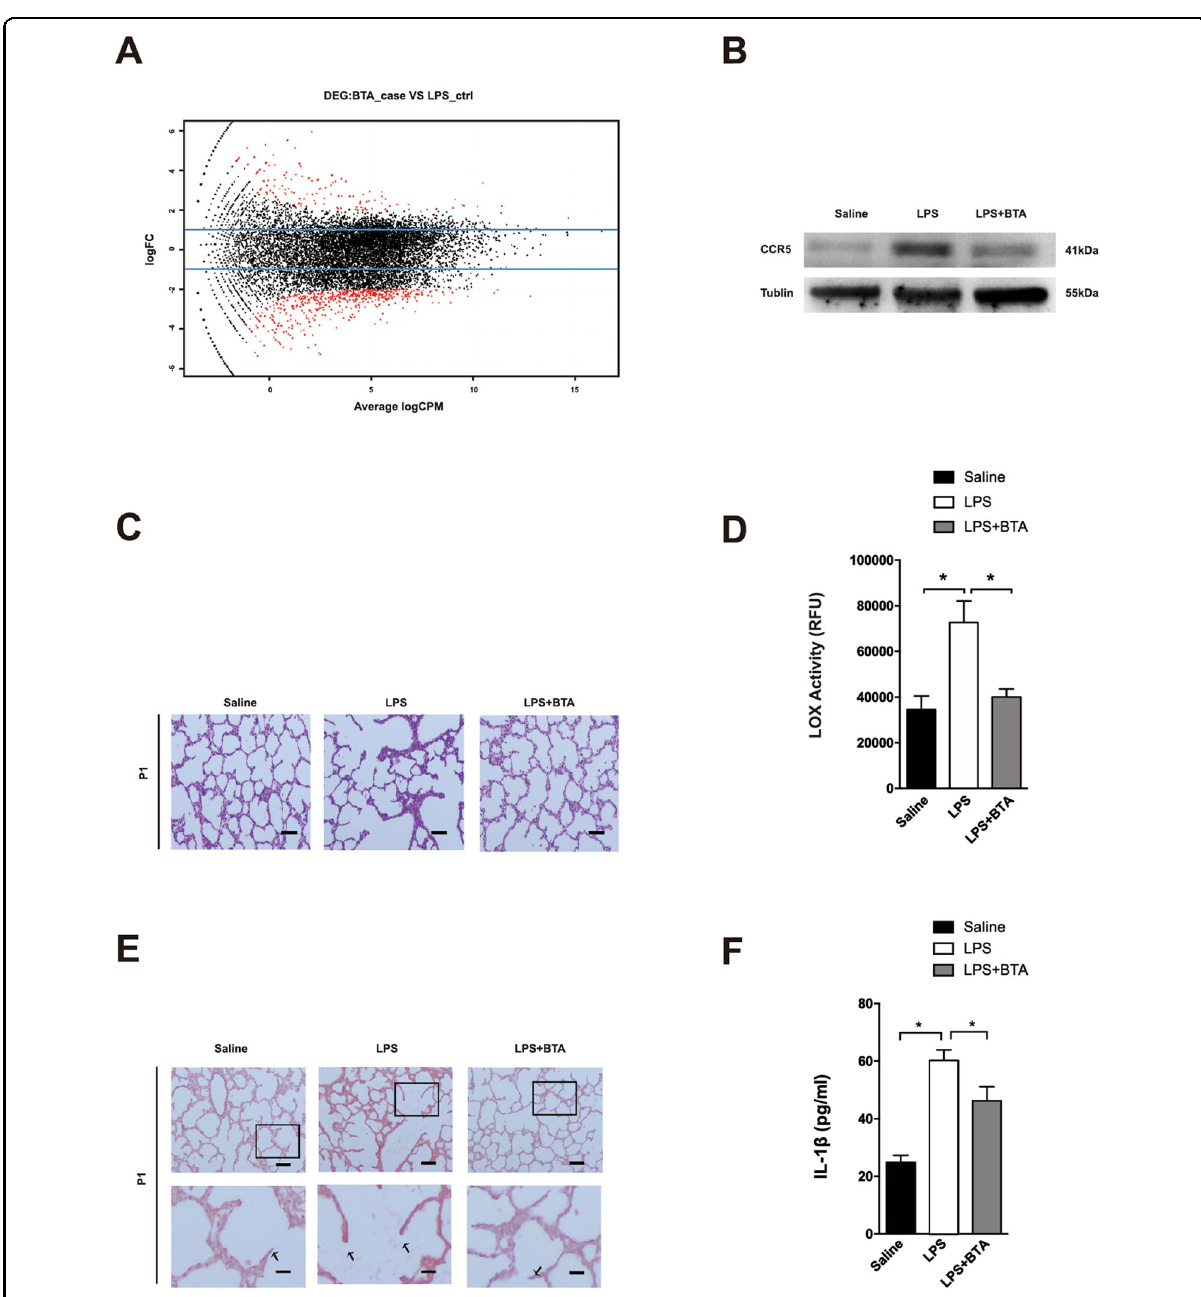
Fig. 7 BTA abated CCR5 function and IL-1 β production to alleviate the simpli fi cation of the lung alveolar in BPD rat model. A RNAseq analysis in LPS and BTA treated primary macrophages. B Representative immunoblot probed for CCR5 in whole lung lysate of P1 rats. C Representative lung sections stained with H&E. Scale bar: 50 μ m. D Treatment with LPS increased LOX activity; adding BTA normalized LOX activity. Data are expressed as mean ± SD ( n = 7), * p < 0.05. E Representative lung sections stained with gomori (Arrows). Top: Scale bar: 50 μ m. Bottom: